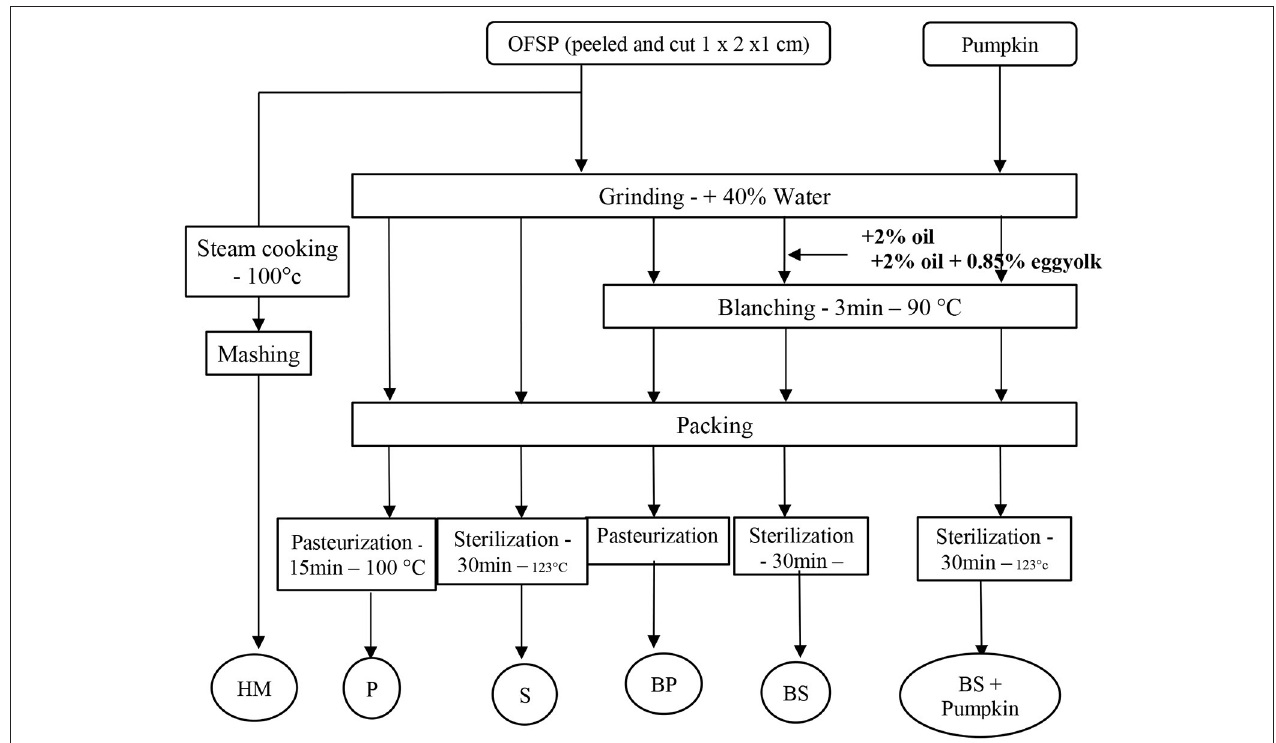
FIGURE 1 | Schematic overview of the experimental process. HM, Home-made Process; BP, Blanching and Pasteurized or BS, Blanching and Sterilized; P, pasteurized, or S,